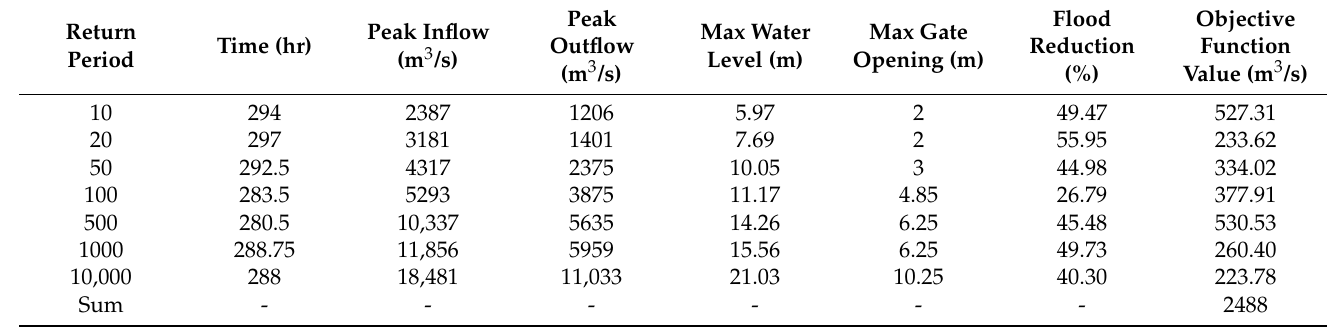
Table 8. Optimized results from simulated optimization model OP1 (genes, 100; population, 80; n = 3).